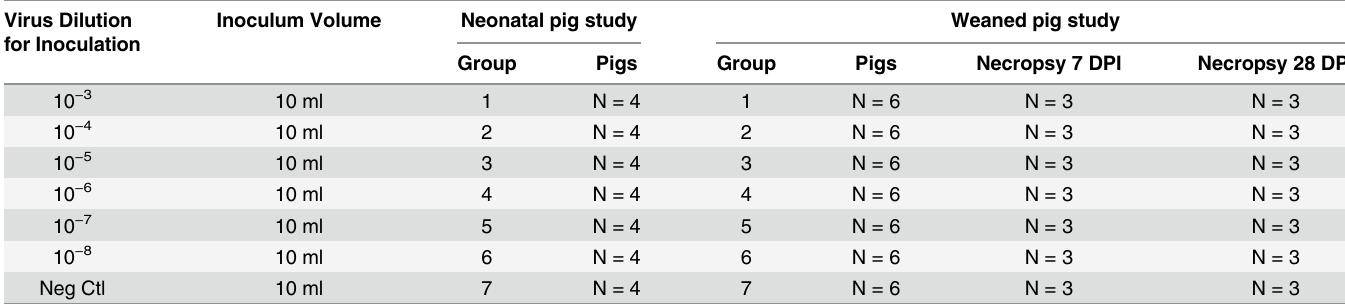
(10ml/pig) (Table 2). Piglets were evaluated daily for clinical signs of vomiting, diarrhea, lethargy, and body condition. Diarrhea severity was assessed with the following criteria by both visual observation and rectal swabbing: ‘ normal ’ = no diarrhea, ‘ mild diarrhea ’ = soft (cowpie), ‘ moder- ate diarrhea ’ = liquid with some solid content, ‘ watery diarrhea ’ = watery with no solid content. Rectal swabs were collected daily from each pig from 0 day post inoculation (DPI) until necropsy Table 2. Experimental Design of the neonatal and weaned pig studies. Virus Dilution Inoculum for Inoculation